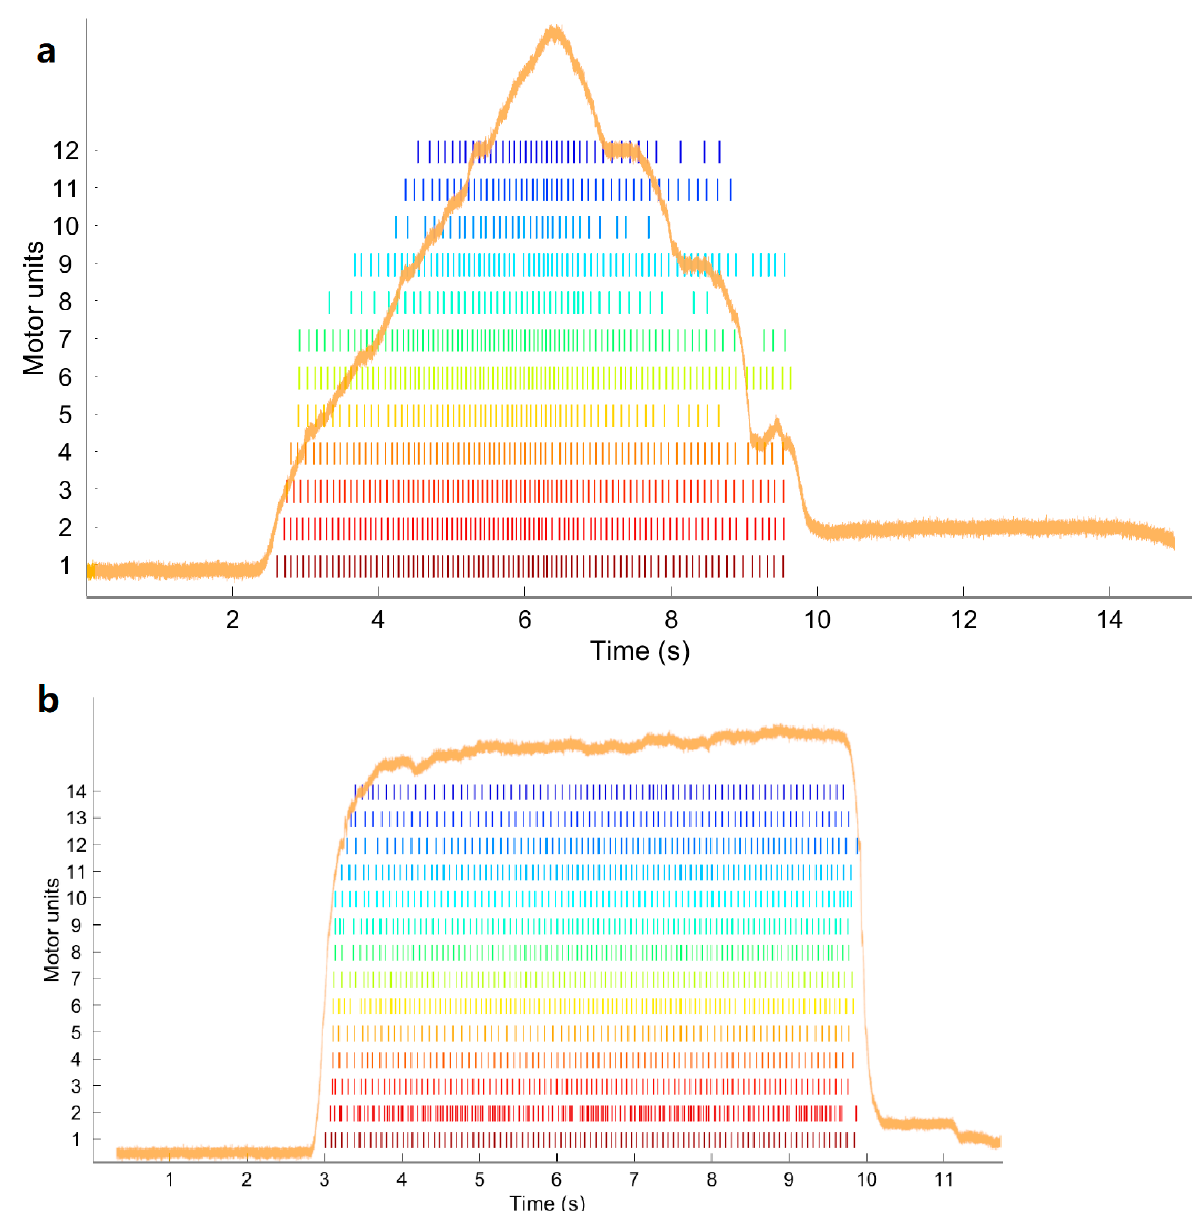
Figure 5. Motor unit (MU) firing time of the detected MUs for subject 2. ( a ) During the “ramp” condition at 10% MVC after control intervention. ( b ) During the “ramp and maintain” condition at 5% MVC after control intervention. A force pattern is depicted in orange.